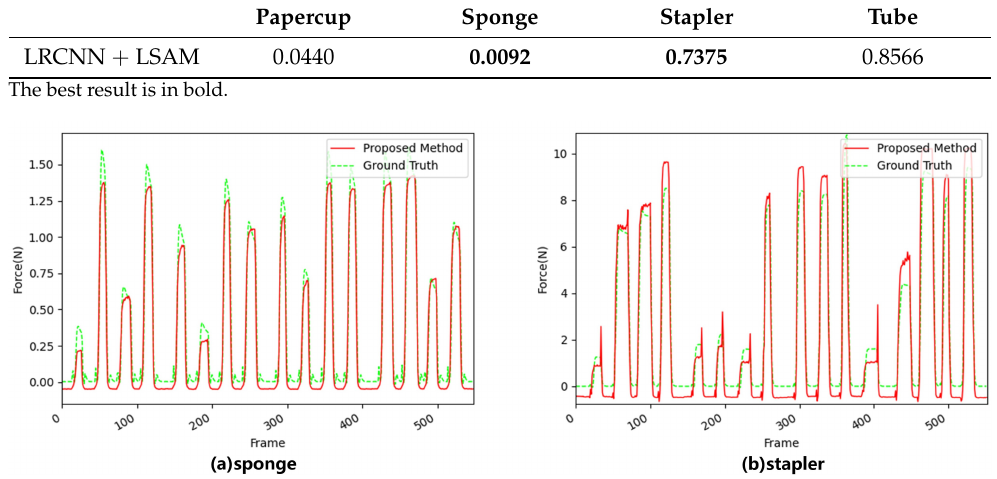
Table 4. Validation loss of the LRCNN with LSAM. Papercup Sponge Stapler Tube